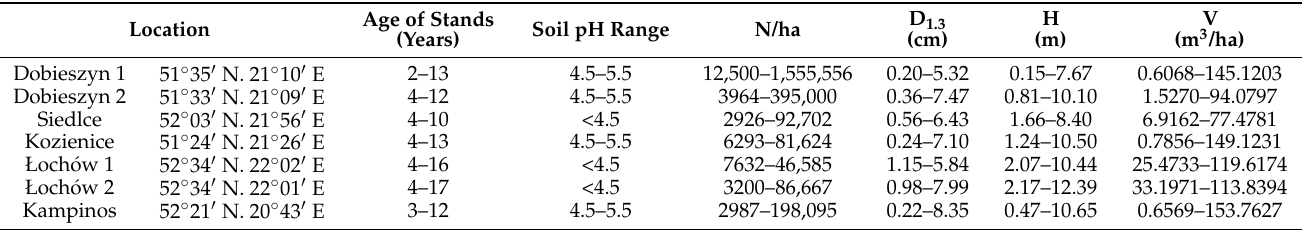
Table 1. Basic characteristics of the surveyed post-agricultural lands. Age of Stands Location Soil pH (Years)